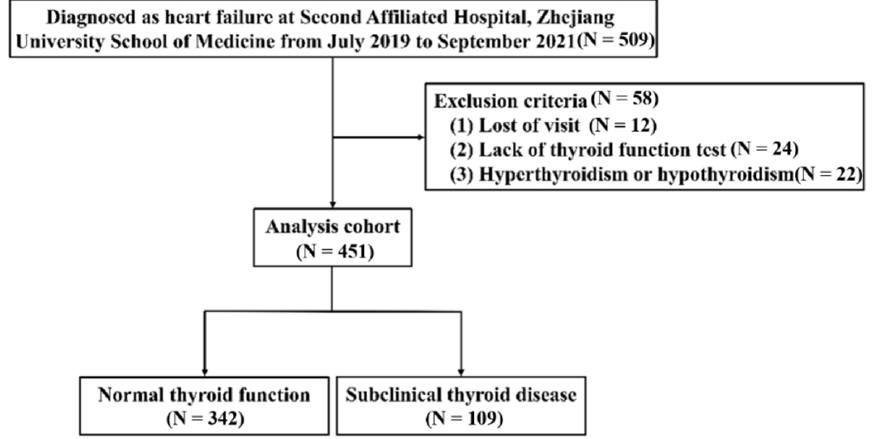
Figure 1. Enrollment and outcomes.